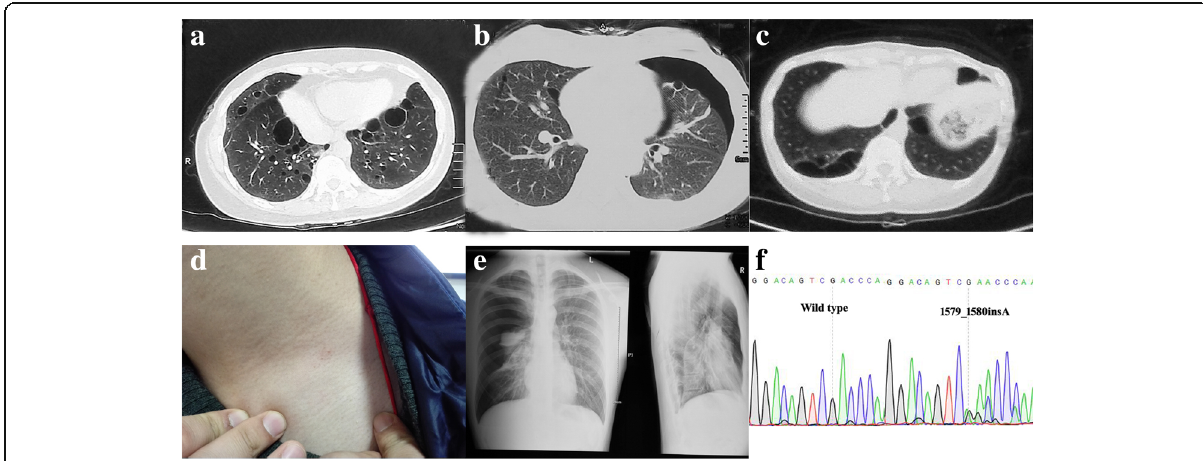
Fig. 2 Examination results and Sequence diagram of family 1. a , b , c Computed tomography scans showing multiple cystic lesions in the lungs of patients (III8 、 III12 、 III14). b , e Computed tomography scan and X-ray examination results showing pneumothorax (III8 、 IV3). d Fat granules on the skin (IV1). f Direct sequencing of exon 14 of FLCN revealed the frameshift mutation: c.1579_1580insA on exon 14